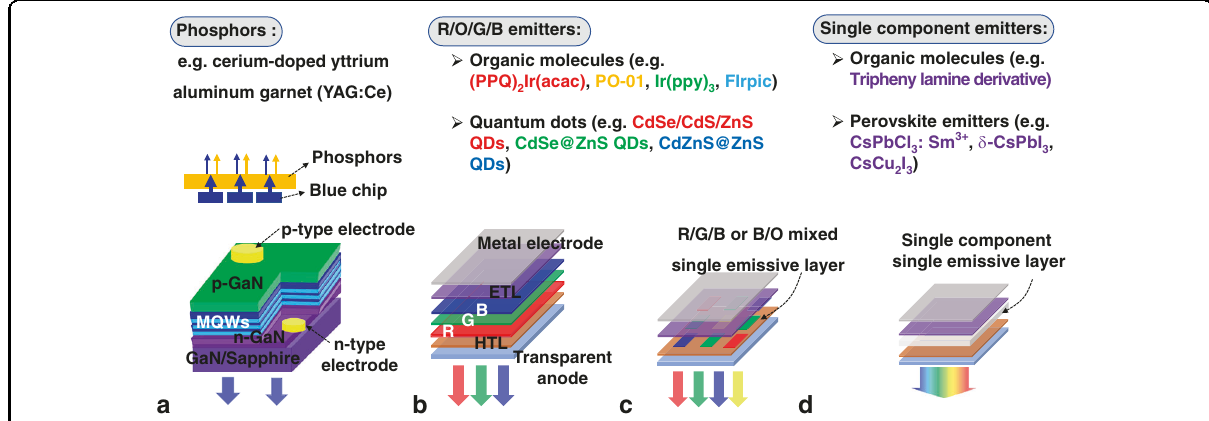
Fig. 3 Emitters and device structures in WLEDs. Device structures of WLEDs based on a GaN – LED, b, c ROGB organic molecules/QDs, and d broad-spectrum emitting materials